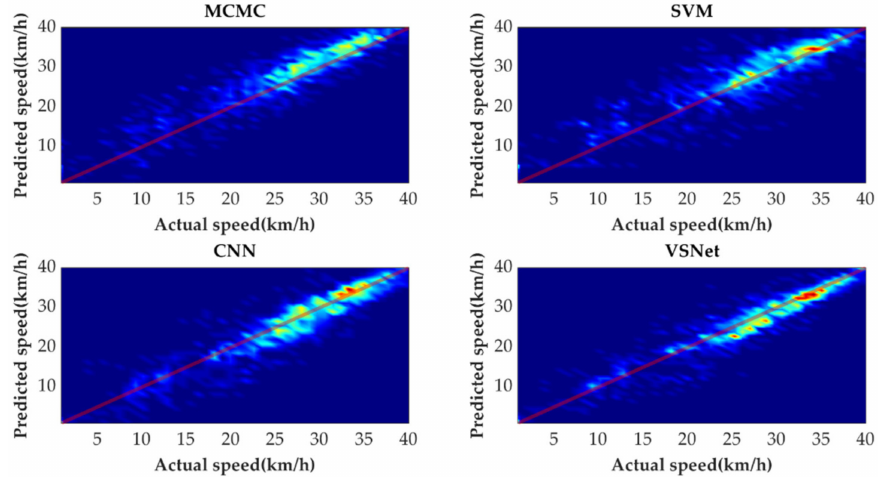
Figure 16. Heat map display of the predicted results for the next 5 s.